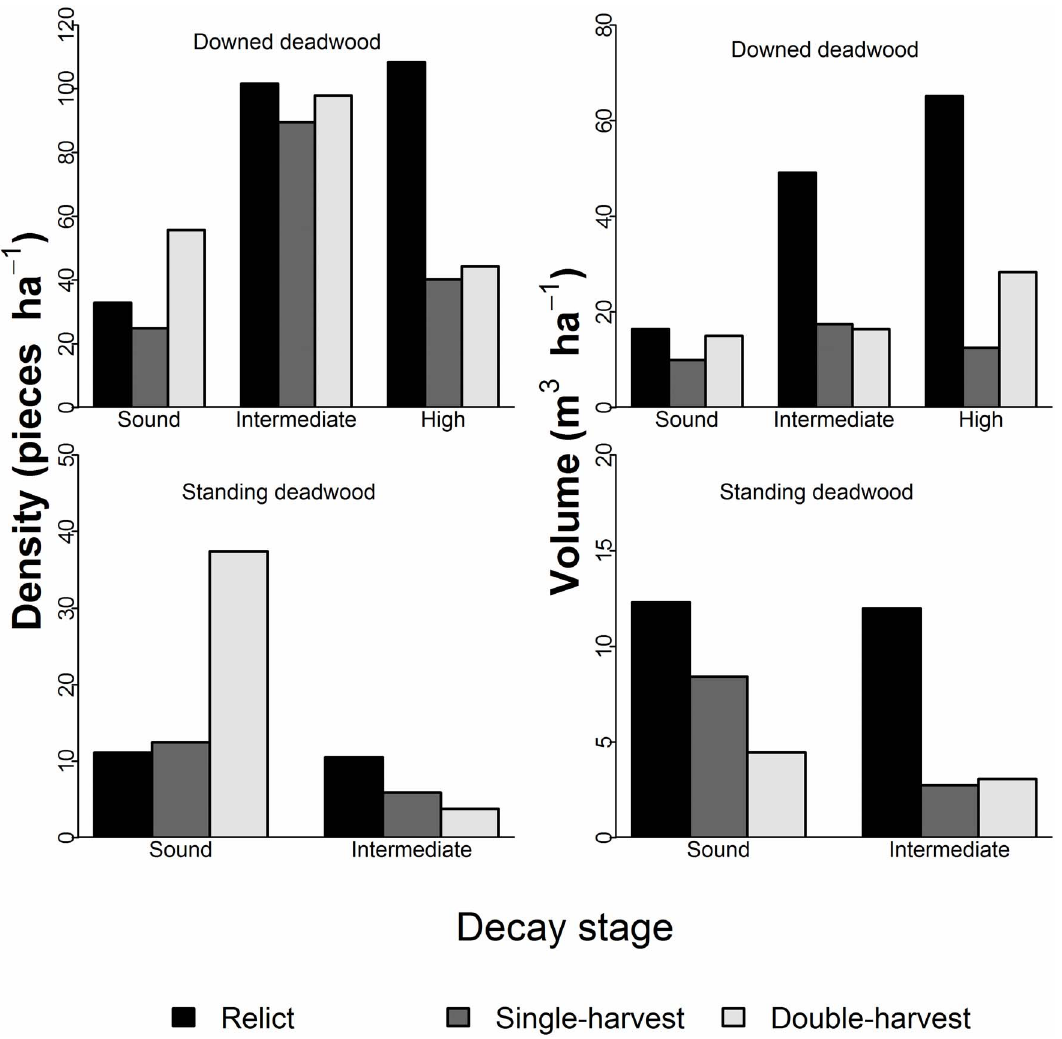
Figure 1. Coarse woody debris decay stage summaries. Downed deadwood (DDW; top row) and standing deadwood (SDW; bottom row) number of pieces ha 2 1 and volume ha 2 1 by decay stage for relict, single-harvest, and double-harvests stands. Decay stages were assigned as: sound, intermediate, or high; for SDW, sound and intermediate categories were used. For a more thorough description, see 2.2 Data Collection.